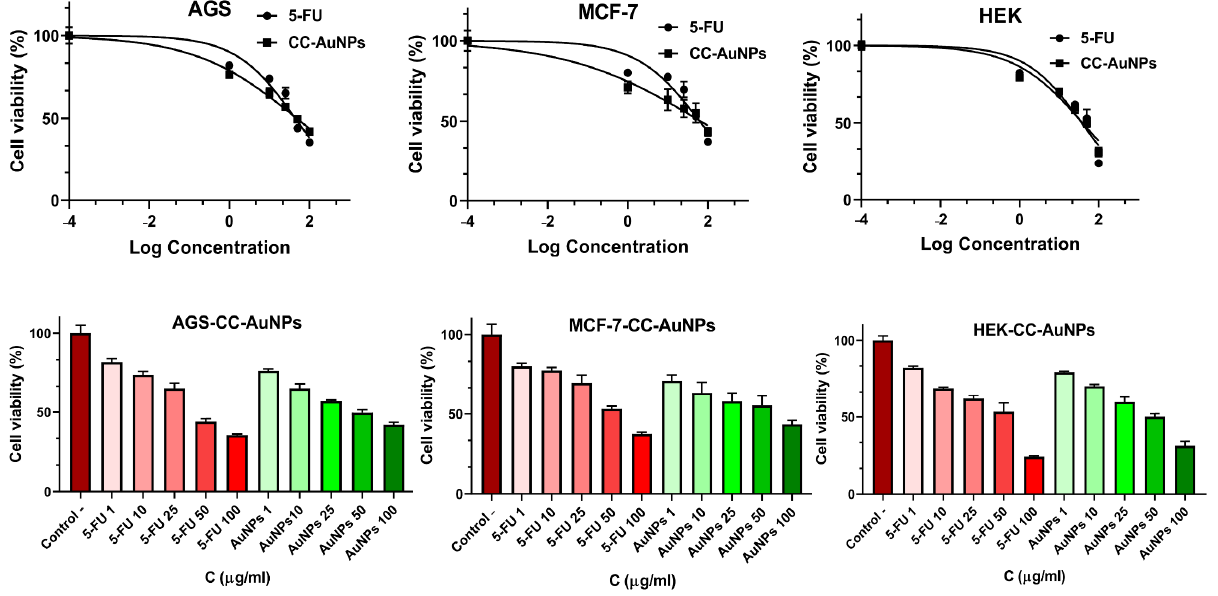
Figure 9. Cytotoxic effects of the prepared CC-AuNPs against MCF-7 and AGS cells and normal HEK cells during the treatment time of 24 h presented on two kinds of graph: log concentration vs cell viability %, and concentration vs cell viability %.